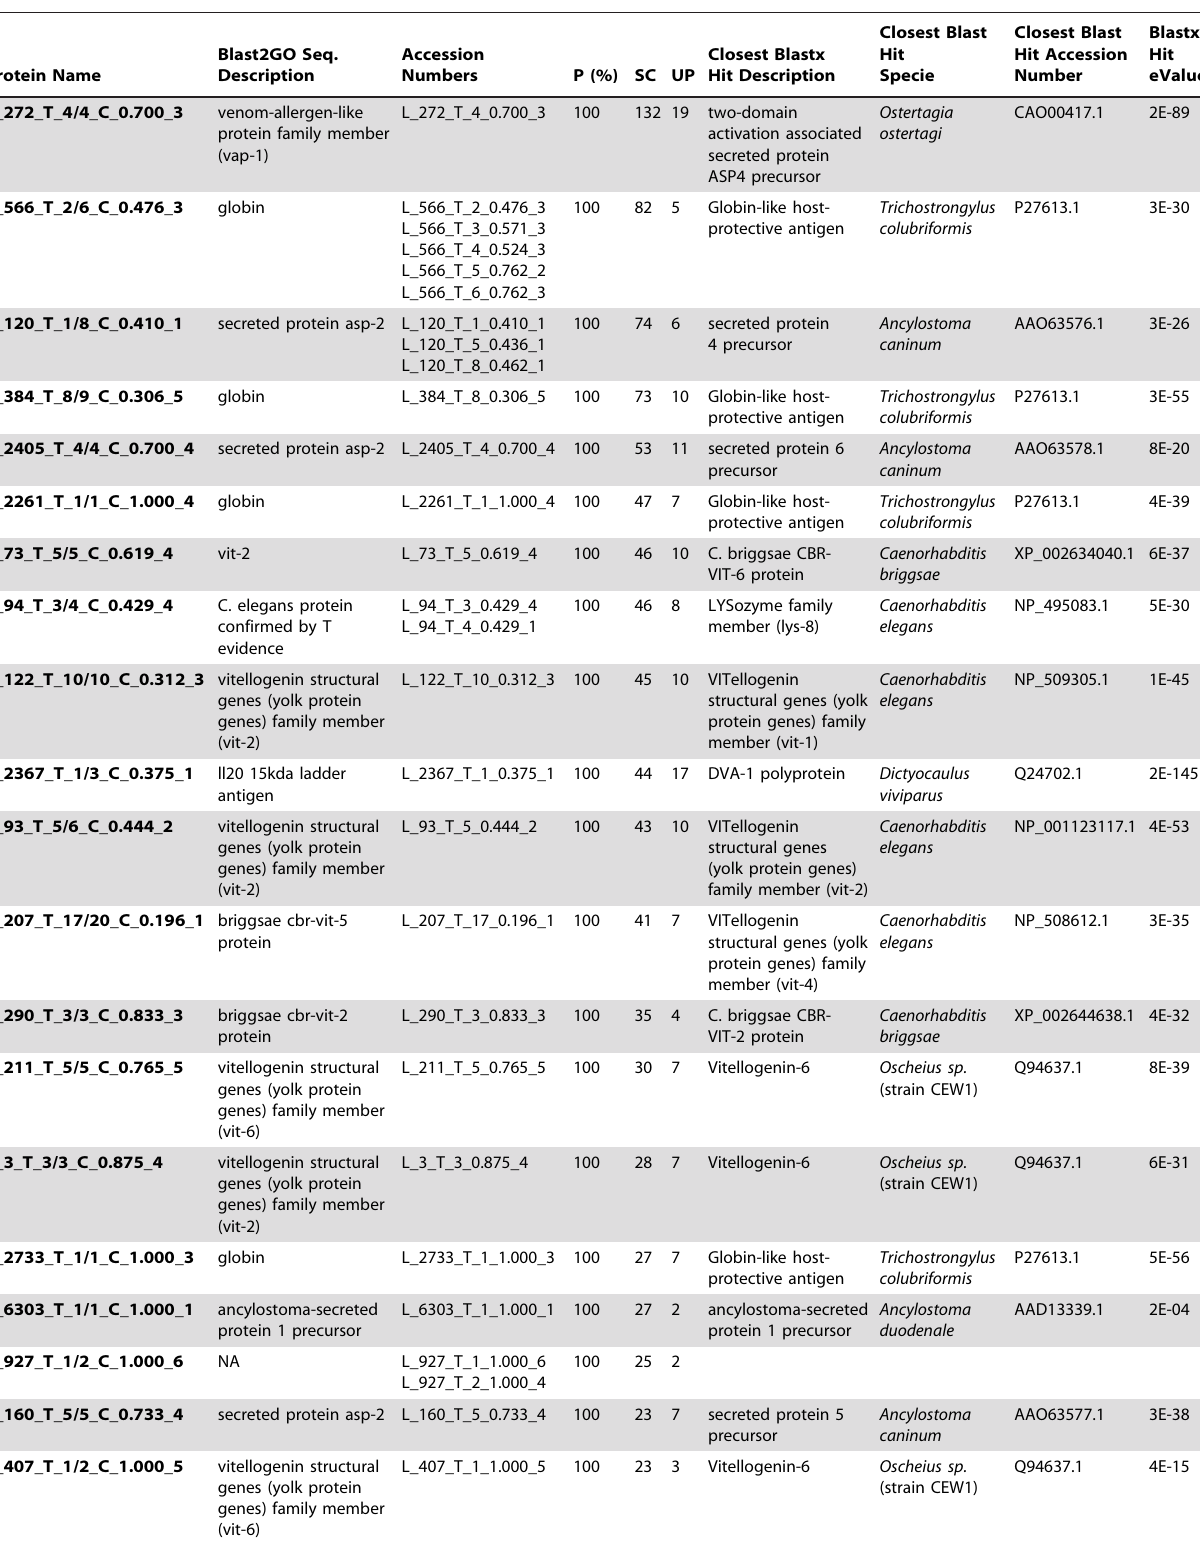
Table 4. Most abundant proteins based on the total spectra identified in ESP from adult H. polygyrus .